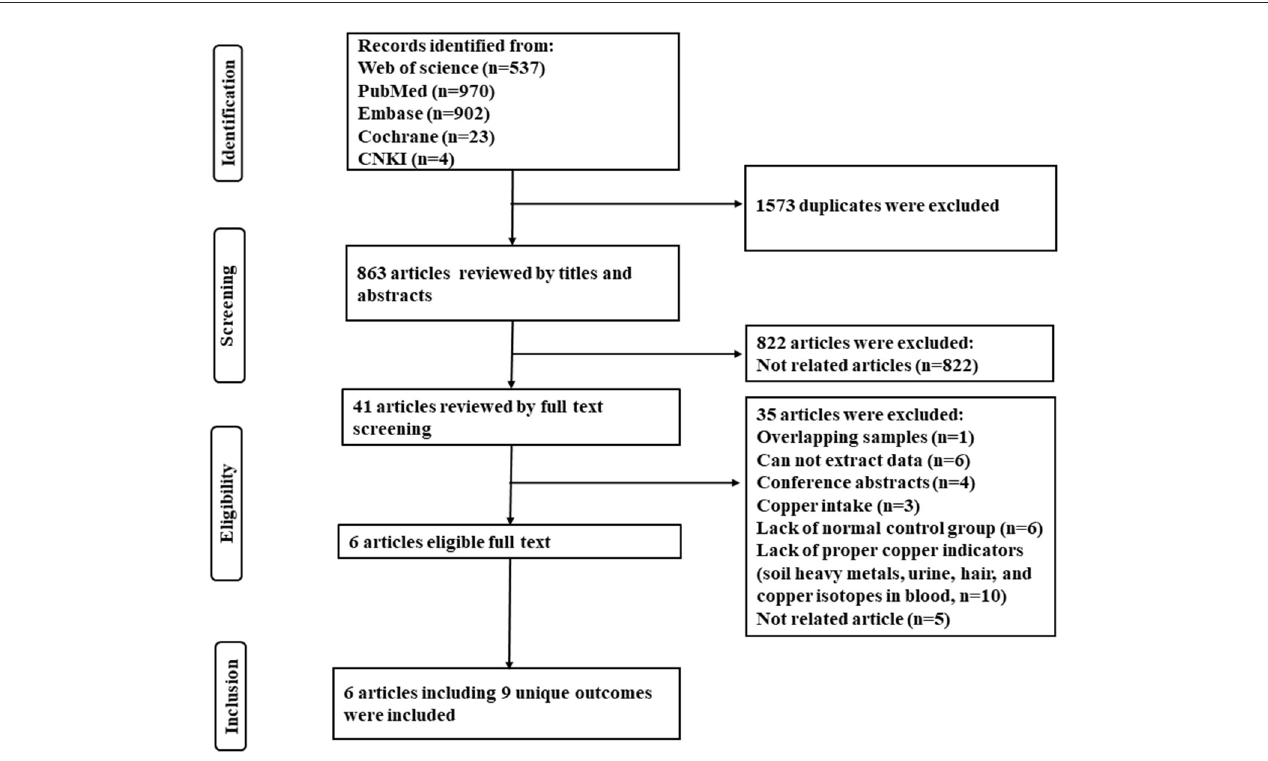
FIGURE1 The PRISMA flow diagram of the study selection